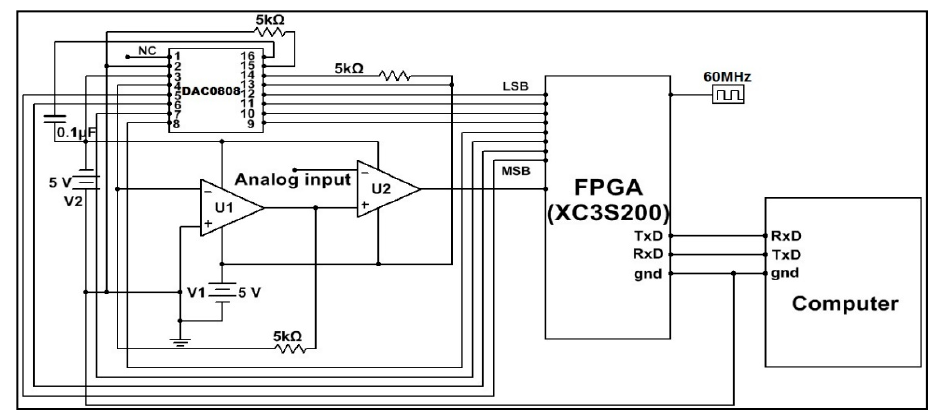
Figure 3. FPGA design of analog input module for a single channel.